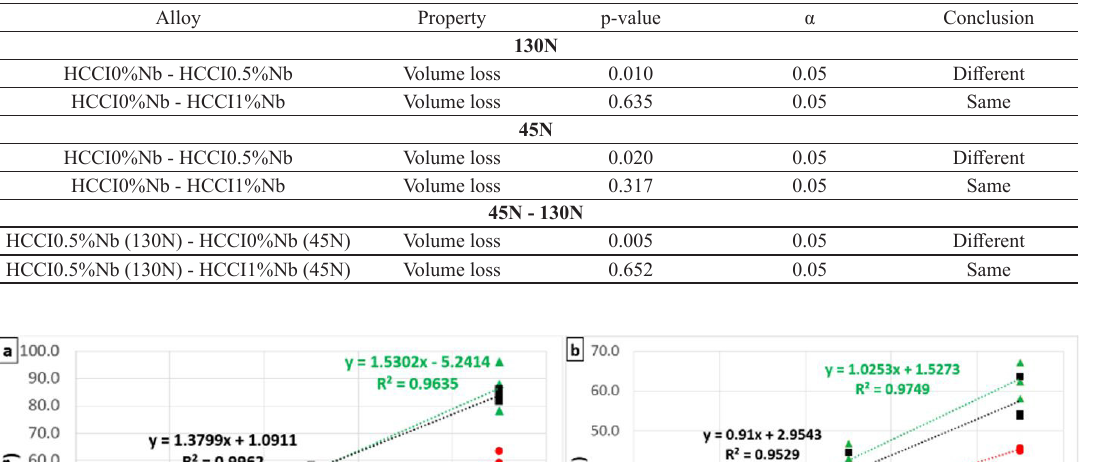
Table 7. Student’s t test of volume losses after 60 minutes of testing.